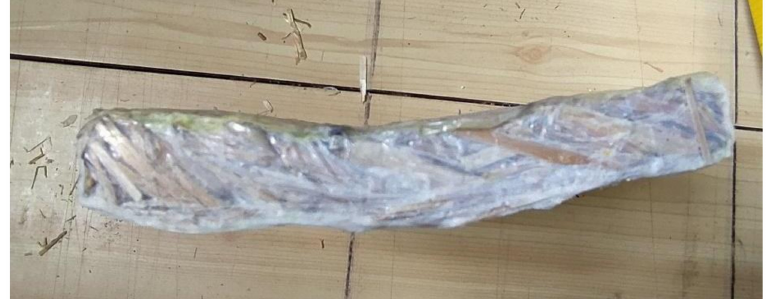
Figure 8. Bending results in normal